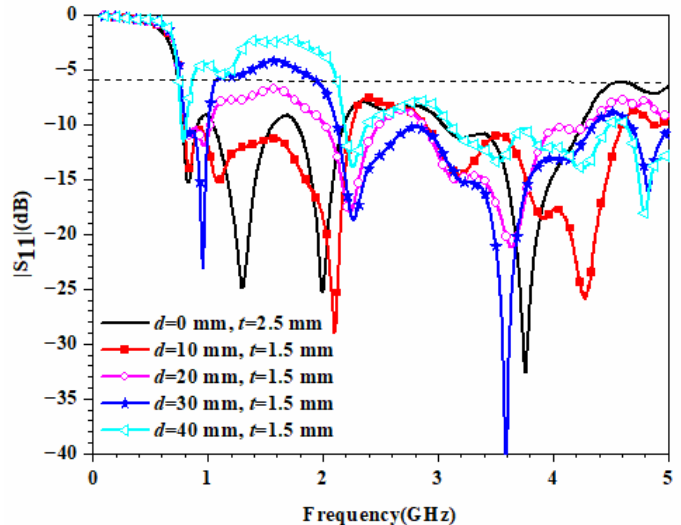
Figure 10. Frequency behavior of measured |S 11 | of the proposed antenna with ferrite slab on the ground plane versus the ferrite’s position.